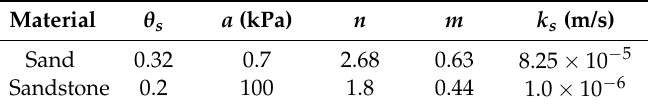
Table 1. Hydraulic properties of slope